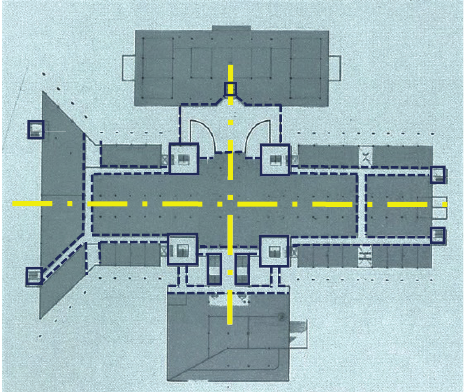
Figure 4. Floor plan, Centro Governmental Dacca, Bangladesh (1962|1983) (Saraiva, 2011, p. 189)